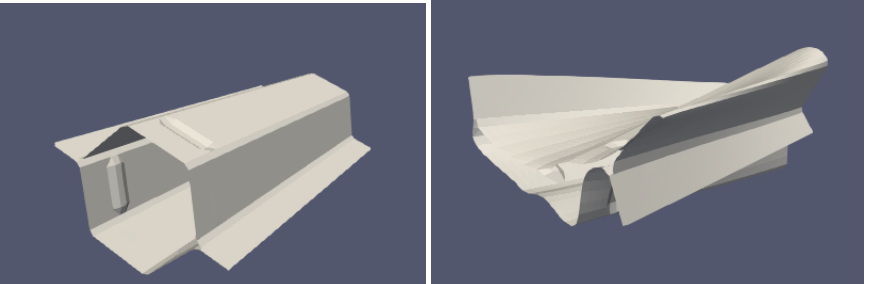
Figure 1. Reference undeformed structure ( left ) and its deformed counterpart ( right ) when a given deformation mode applied on the reference